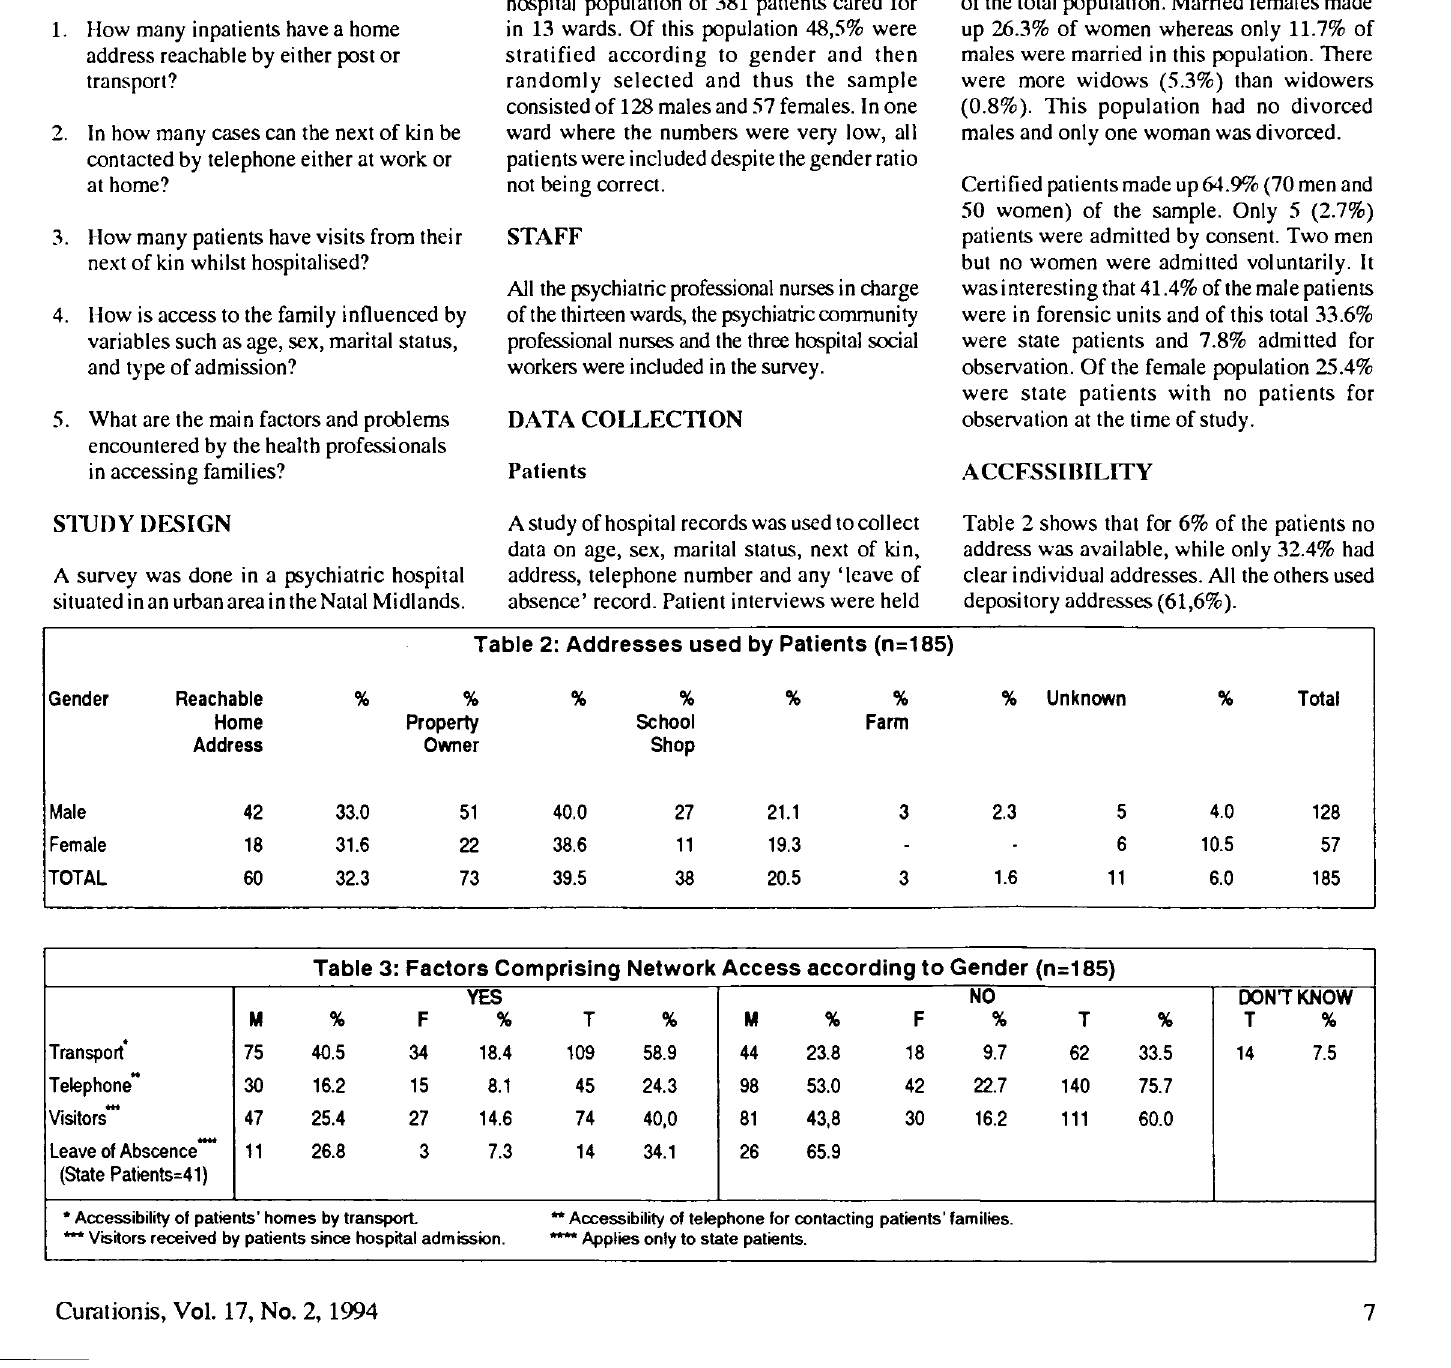
Table 3: Factors Comprising Network Access according to Gender